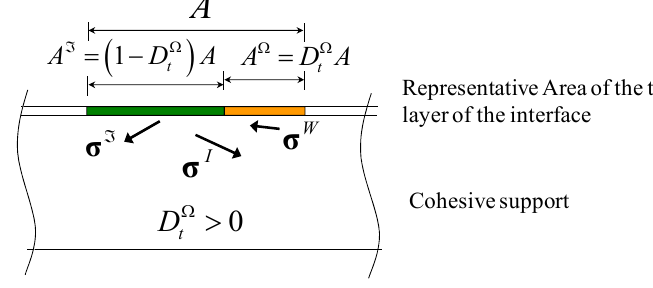
Figure 1: Representative area of the third layer of the